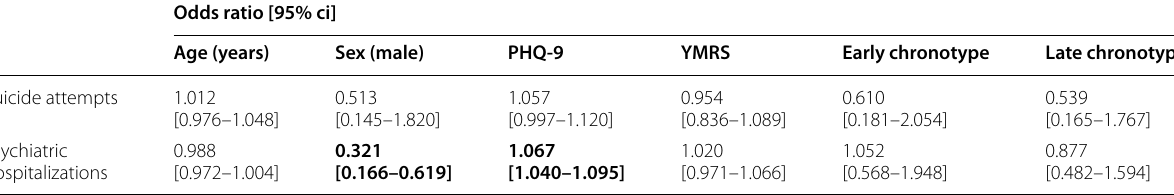
Females and normal chronotype were used as reference groups Bold ORs are significant at p <